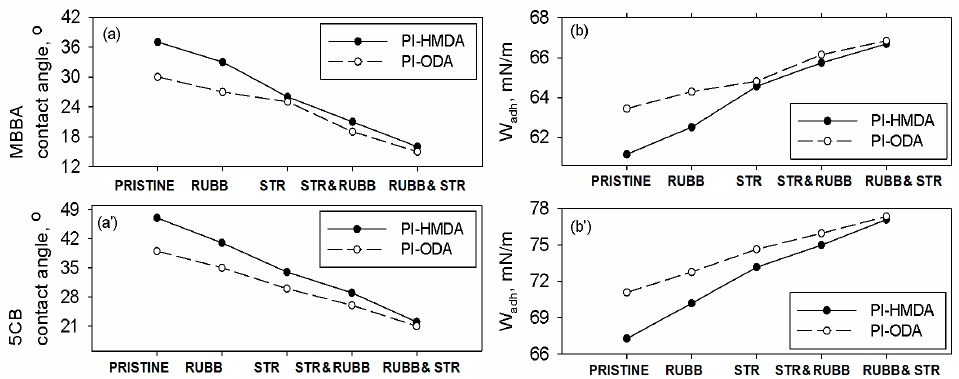
Figure 9. The variation of the ( a ) MBBA and ( a’ ) 5CB contact angle and work of adhesion of ( b ) MBBA and ( b’ ) 5CB with the surface treatment applied to the PI film.